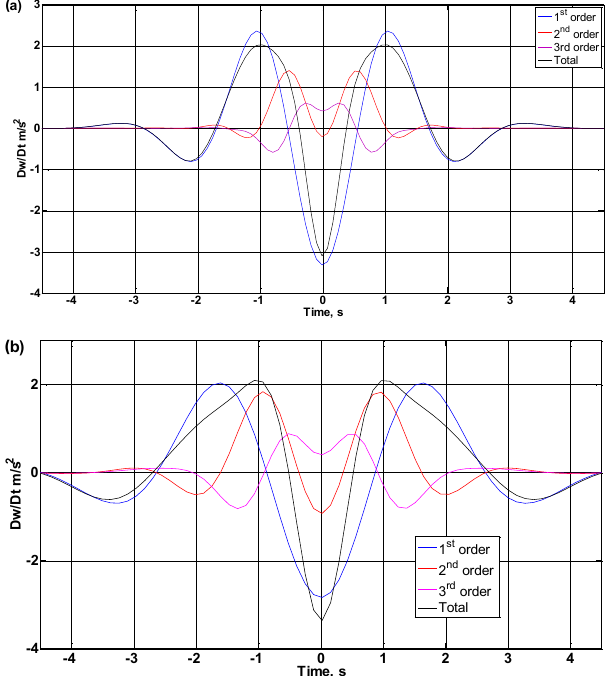
Fig. 5. Lagrangian vertical acceleration a L at the focusing loca- tion for ε = 0 . 3: (a) T 0 = 2 . 8s, λ 0 = 12 . 1m; (b) T 0 = 4 . 34s; λ 0 = 25 .